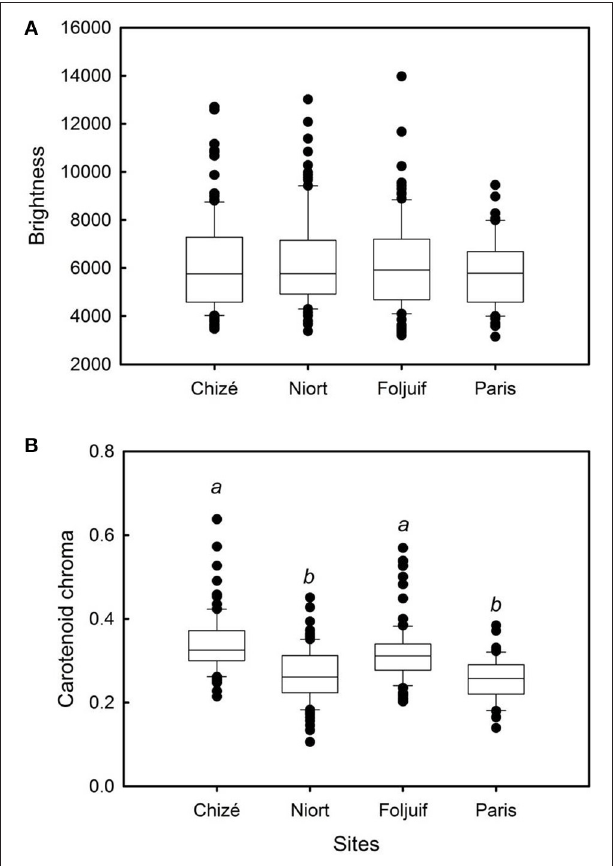
FIGURE 2 | Variation of yellow feather color among breeding sites in great tit nestlings: (A) brightness and (B) carotenoid chroma. Nestling feathers were significantly more chromatic in both woodland sites of Foljuif and Chizé as compared to both urban sites of Paris [ t (df : 349) = 3.68, adj. p = 0.001; t (df : 349) = 4.76, adj. p < 0.0001] and Niort [ t (df : 349) = 3.32, adj. p = 0.005; t (df : 349) = 4.57, adj. p < 0.0001], respectively. Different letters indicate significant